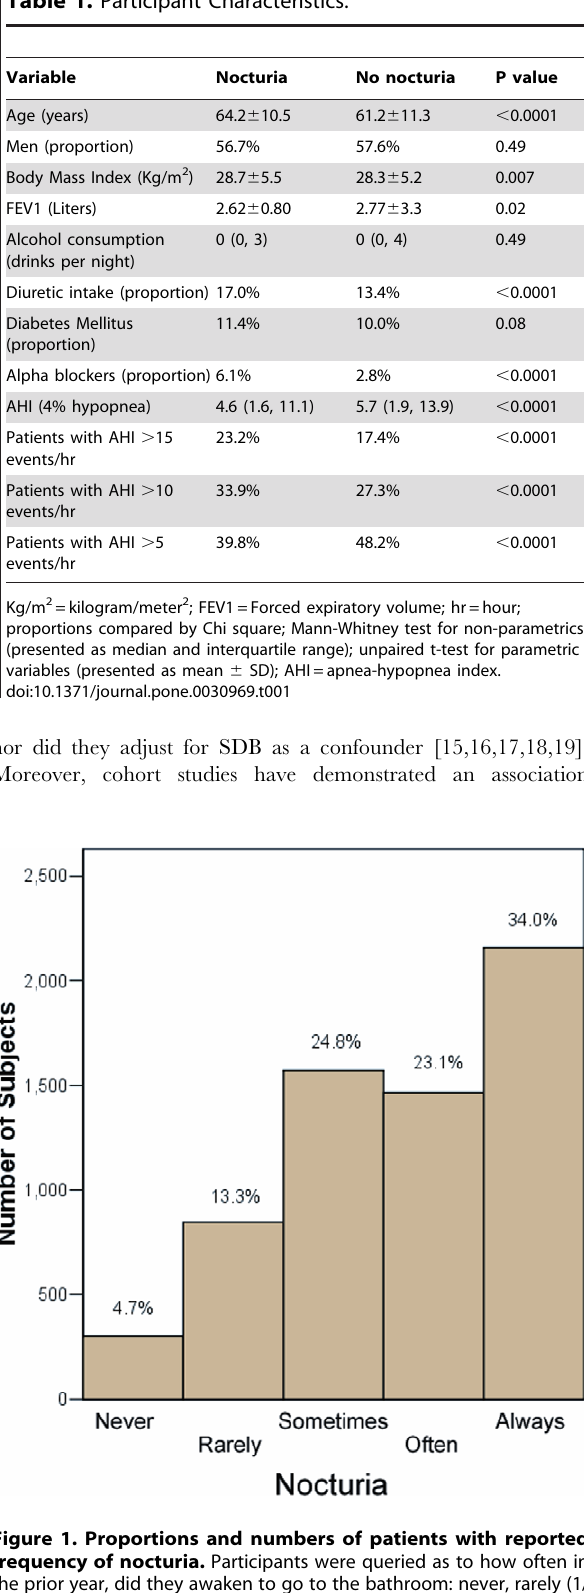
Table 1. Participant Characteristics.